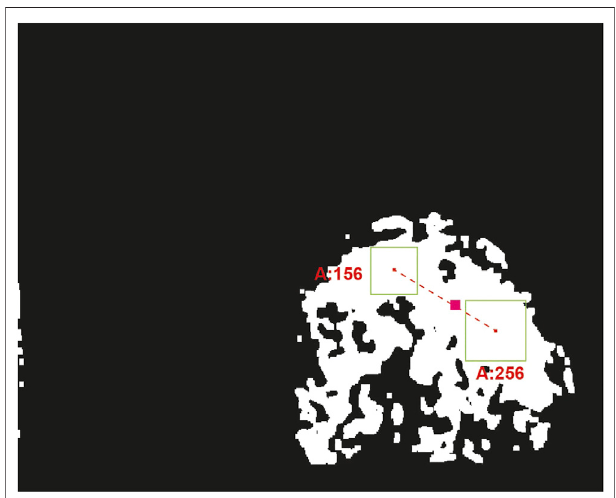
FIGURE 10 | Centroid estimation of the ball by pondering all detected clusters. This fi gure shows a mask where the black pixels represent visual information completely outside the range of colors of the red ball, de fi ned in the HSV color space. The white pixels represent the part of the image that has color information within the established range. The green boxes represent two spots detected. The pink line joins green boxes centroids and the pink box isthe estimation ofthe centroid given tothepositionand areas of green